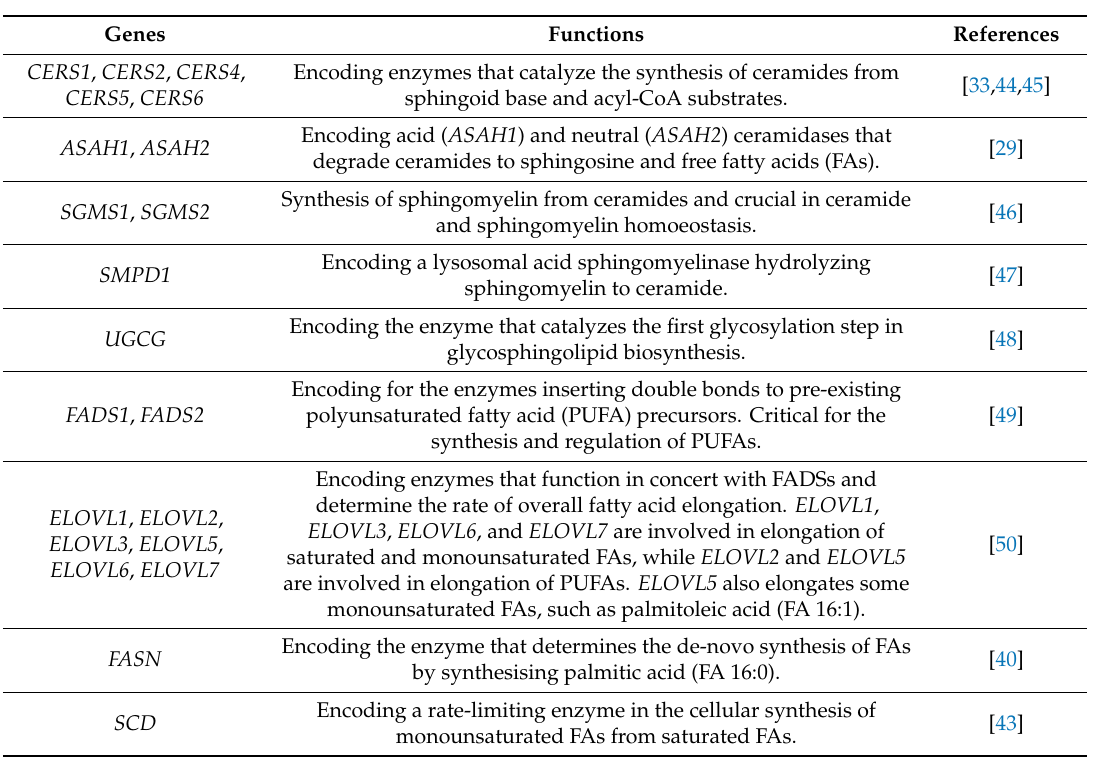
Table 1. List of key genes involved in the lipid and fatty acid metabolism and their function. Genes Functions CERS1 , CERS2 , CERS4